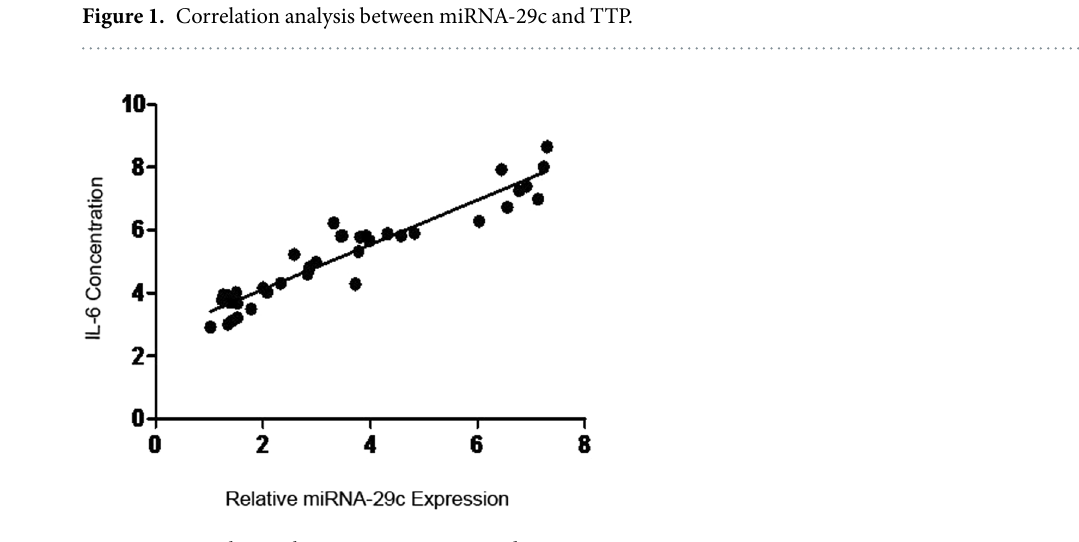
Figure 2. Correlations between miRNA-29c and